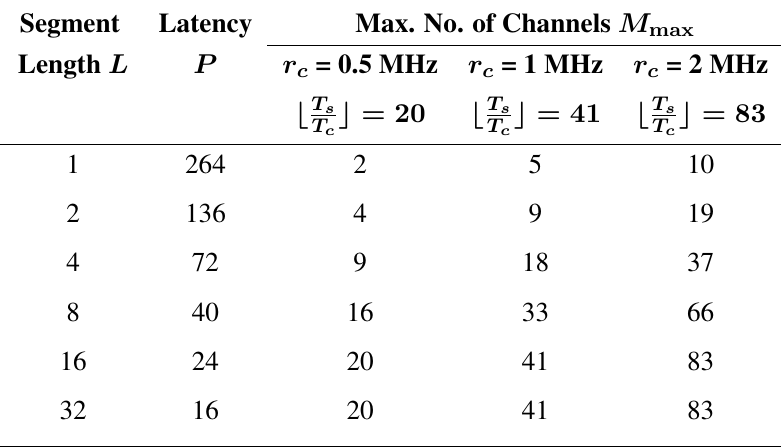
Table 6. The latency P of the GHA circuit and the maximum number of channels M max for various segment lengths L and clock rates r of the proposed spike sorting circuit. The c = 24,000 samples/s. The minimum number of samples sampling rate of spike trains is r s between the peak of successive spikes from the same channel is assumed to be Q = 32